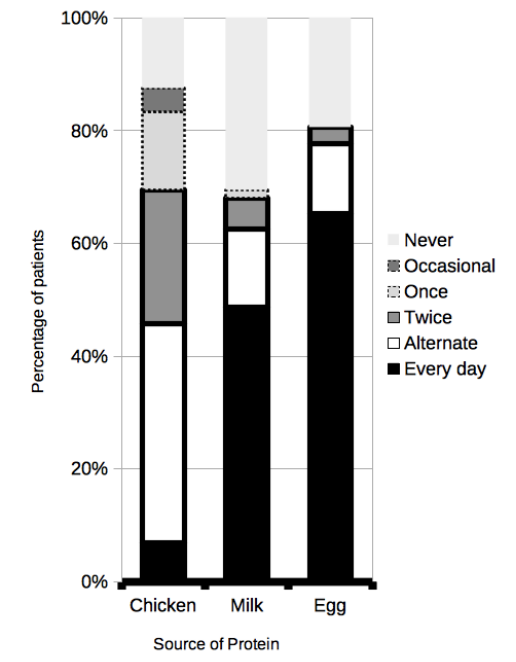
Figure 4: Bar diagram showing source of protein in respondents’ meal and its percentage.